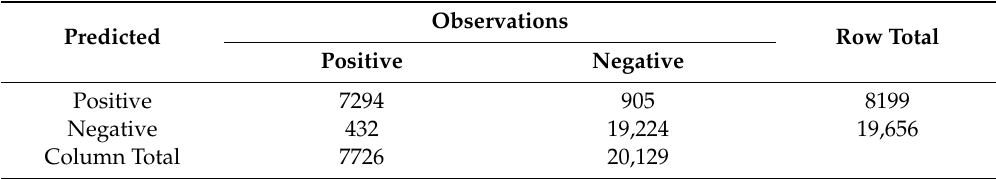
during the major event of January 2020 as